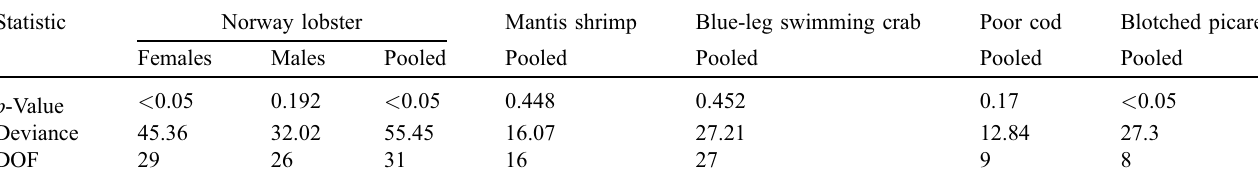
while horizontal dashed lines represent the baselines of no effect.